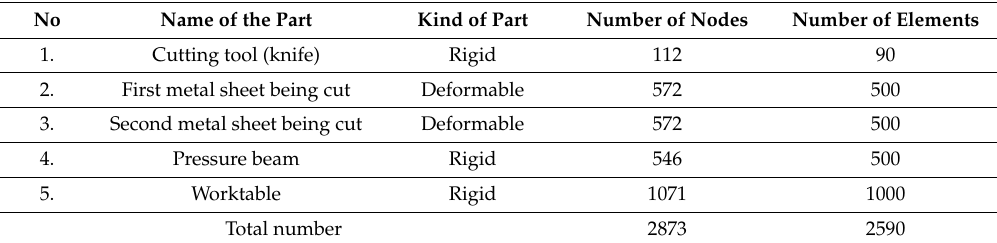
Table 2. Information about parts discretized into finite elements and nodes.